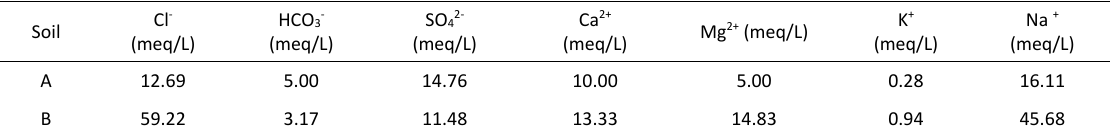
Table 4: Cations and anions availability in the soils